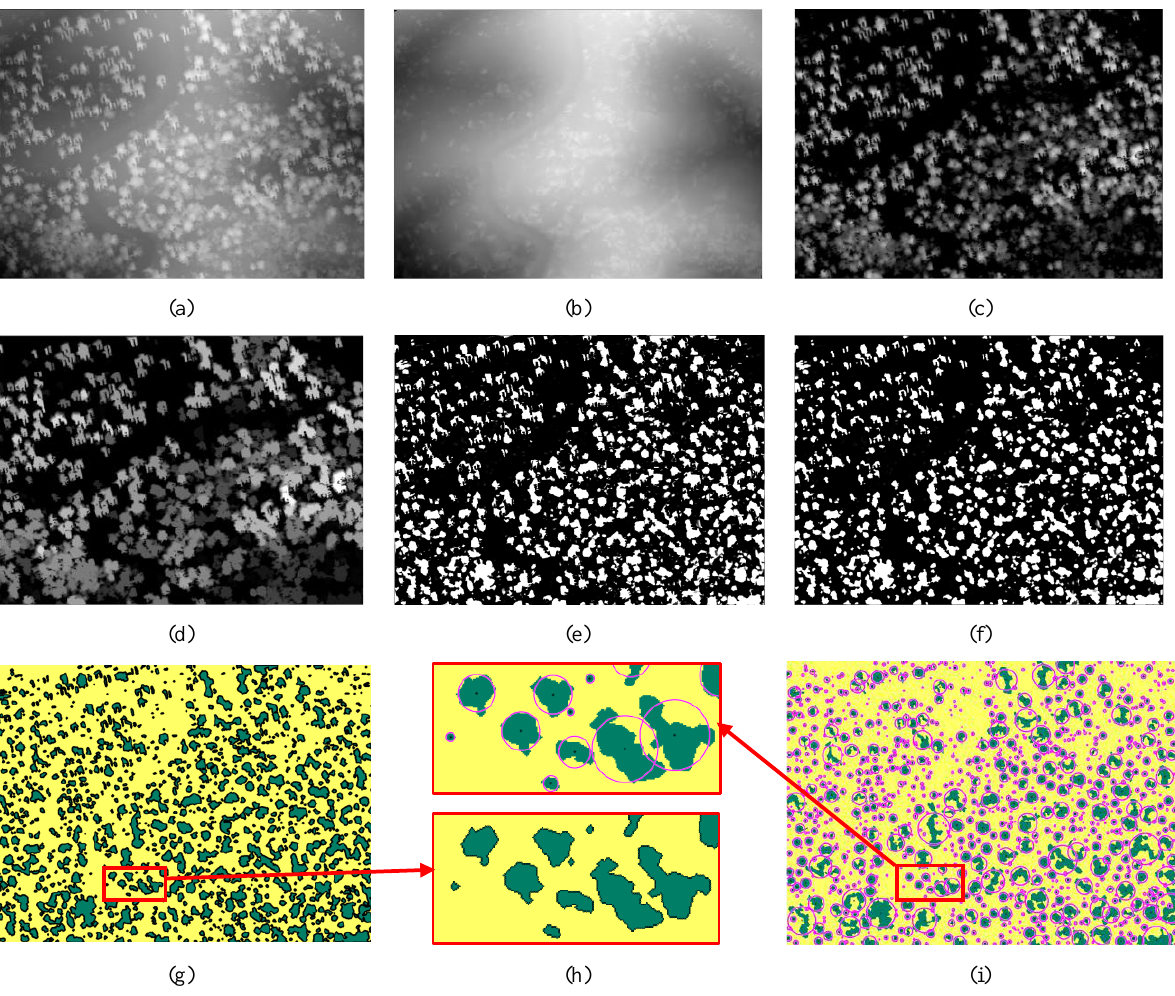
Figure 6. The qualitative results of the proposed method are: (a) DSM, (b) DTM, (c) CHM, (d) the result of reconstruction, (e) the segmentation result, (f) the postprocessing result, (g)the representation of the segment borders, (i) Representation of circles and centers of individual trees.